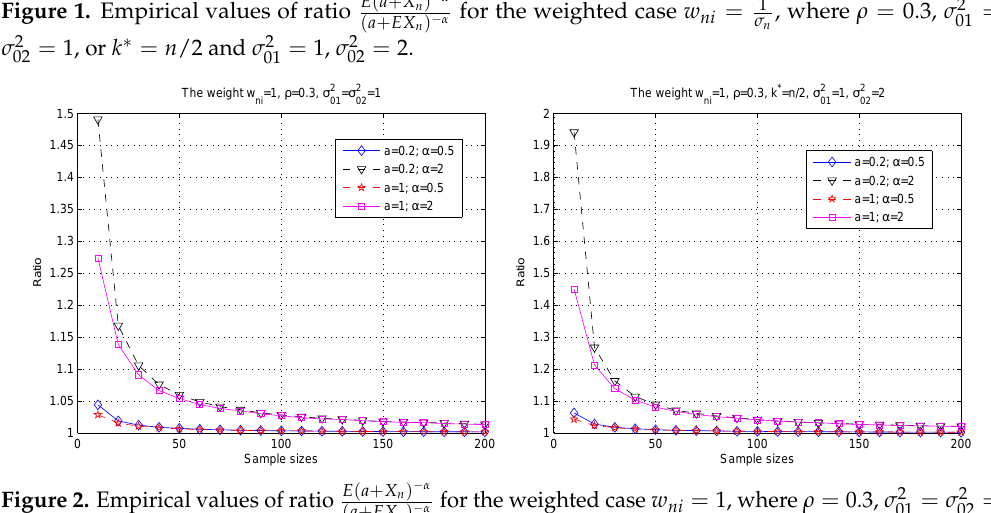
Figure 2. Empirical values of ratio E ( a + X n ) 1, or k ∗ = n /2 and σ 2